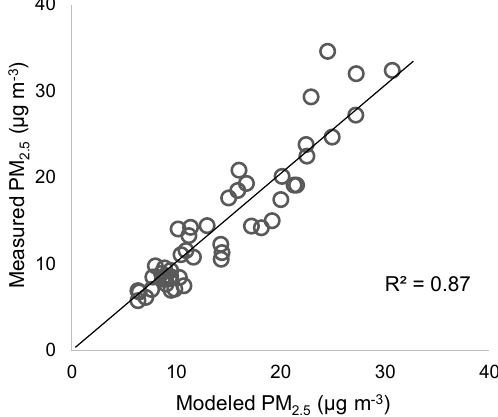
Figure 12. Measured vs. PMF model reconstruction of PM 2 . 5 mass concentration (unit is µgm − 3